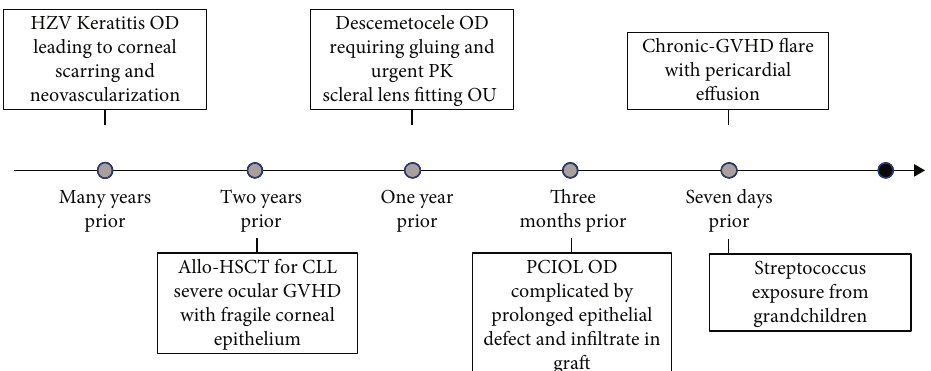
Figure 1: Timeline of history of present illness. Graphical representation of the ocular and systemic disease course for this patient.